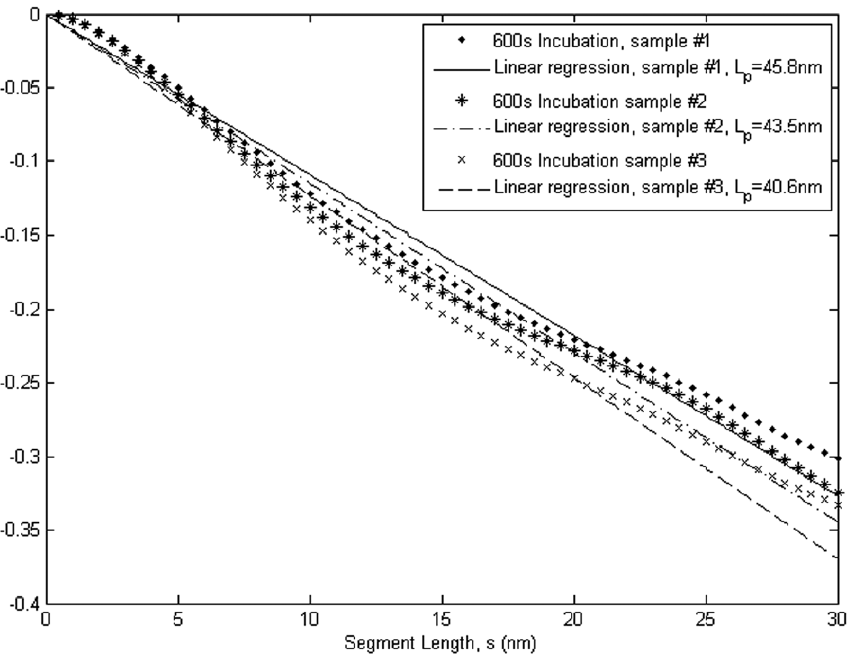
Figure 4. Tangent angle correlation analysis shows that L p of WT human cardiac a Tm equals 40.6 2 45.8 nm. ln( , cos( h ) . ) data obtained from three separate samples independently prepared under identical conditions are plotted as a function of segment length along the molecular contour. The slope of this plot is –1/2L p . L p for WT Tm from this analysis were 45.8 6 0.8 nm (N=741, R 2 =0.99), 43.5 6 0.8 nm (N=628, R 2 =0.98) and 40.6 6 0.8 nm (N=798, R 2 =0.98). The variation in the L p values represents the uncertainty inherent to our experimental setup and the tangent angle correlation analysis.